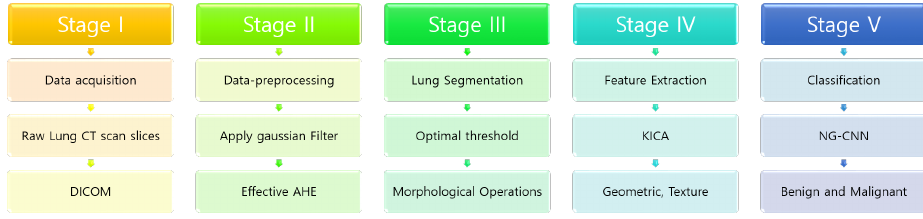
Figure 1. Overall flow of our proposed lung nodule